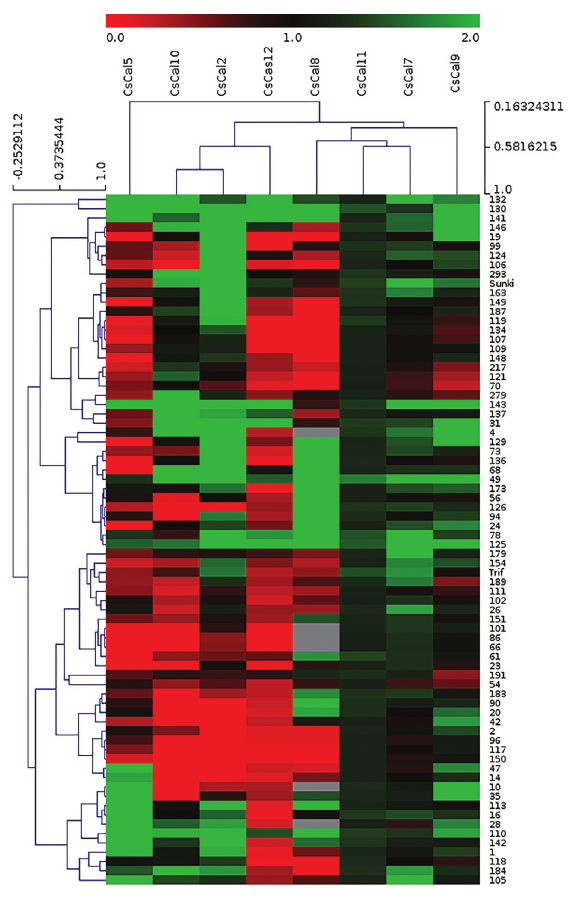
Figure 5 - Heatmap of the gene expression profile by clustering analysis between the eight CscalS genes evaluated using the 74 genotypes (72 hy- brids and the parent plants P. trifoliata and C. sunki ). The heatmap was made using fold-change normalized data as inputs to the MeV (MultiExperiment Viewer) program v. 4.9 (http://sourceforge.net/pro- jects/mev-tm4/). The names of genes and gene hierarchical clusters are shown at the top. Fold-change expression values ranged from green (high- est expression) to red (lowest expression). The sample names (74 geno- types) are shown on the right side, while the sample hierarchical cluster is shown on the left side.